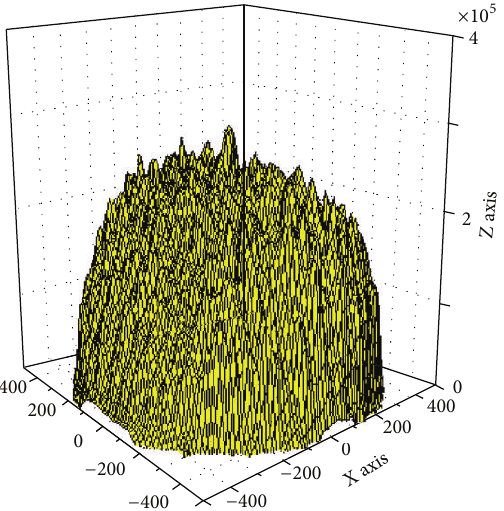
Figure 20: Energy consumption of uniformly deployed network.